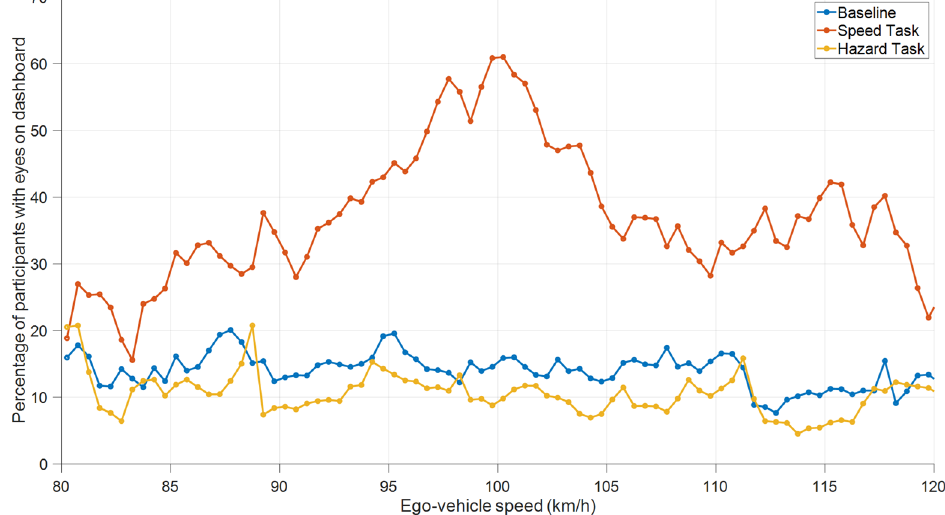
Figure 10. Percentage of participants with their eyes on the dashboard as a function of vehicle speed in the Baseline Task, Speed Task, and Hazard Task (Videos 1–3 combined, first 5 s of each video excluded).